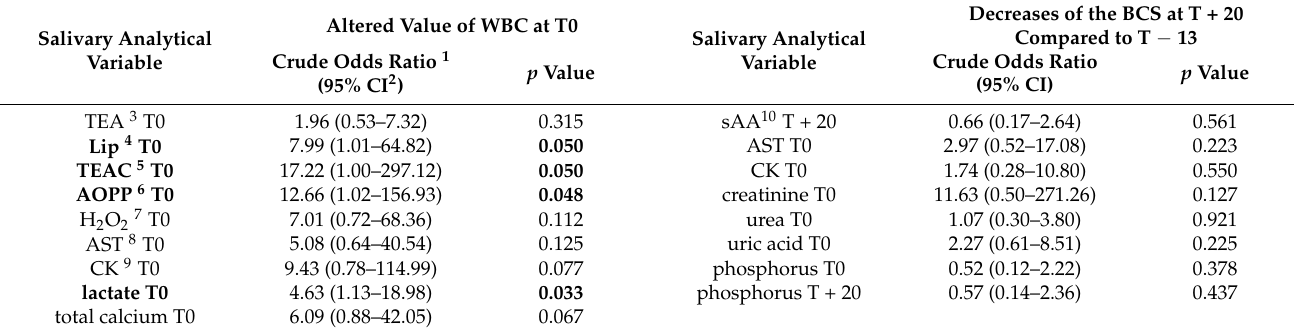
Table 2. Multiple logistic regression analyses in 13 dairy cows during their peripartum period between the altered white blood cell (WBC) at T0 ( ≤ 4.0 or ≥ 12.0 × 10 9 cel/L [20]), and decreases in the body condition score (BCS) at T + 20 compared to T − 13 with some salivary analytes at different time of samplings. The times were T − 13: at − 13 ± 6.91 days relative to calving; T0: within the 12 first hours after calving; T + 7: seven days after calving; T + 20: 20 days after calving. The analytical variable in bold showed significance.